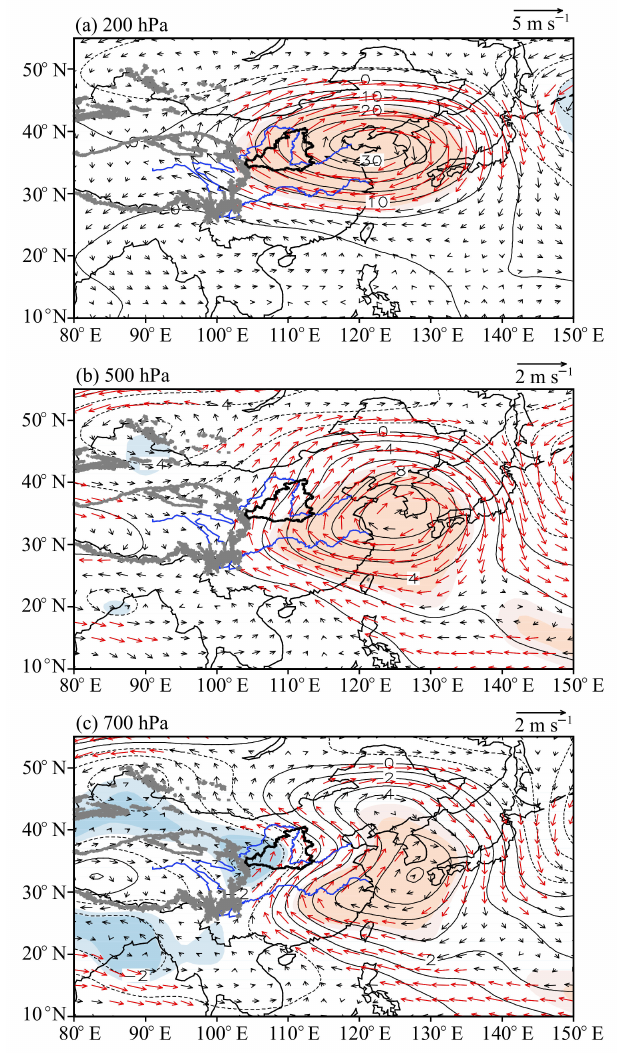
Figure 2. ( a ) Anomalies of September 200 hPa geopotential heights (contours; units: gpm) and winds (vectors; units: m s − 1 ) obtained by regressing upon the simultaneous observational MRYR precipitation index during the period 1979–2021; ( b , c ) As in ( a ), but for 500- and 700-hPa levels. Shadings represent anomalies in geopotential heights significant at the 90 and 95% confidence levels. Red vectors denote anomalous winds significant at the 95% confidence level. The black bold borderline around the Yellow River (the blue curve in north China) represents the MRYR region and the thick gray contour denotes the Tibetan Plateau (3000 m above sea